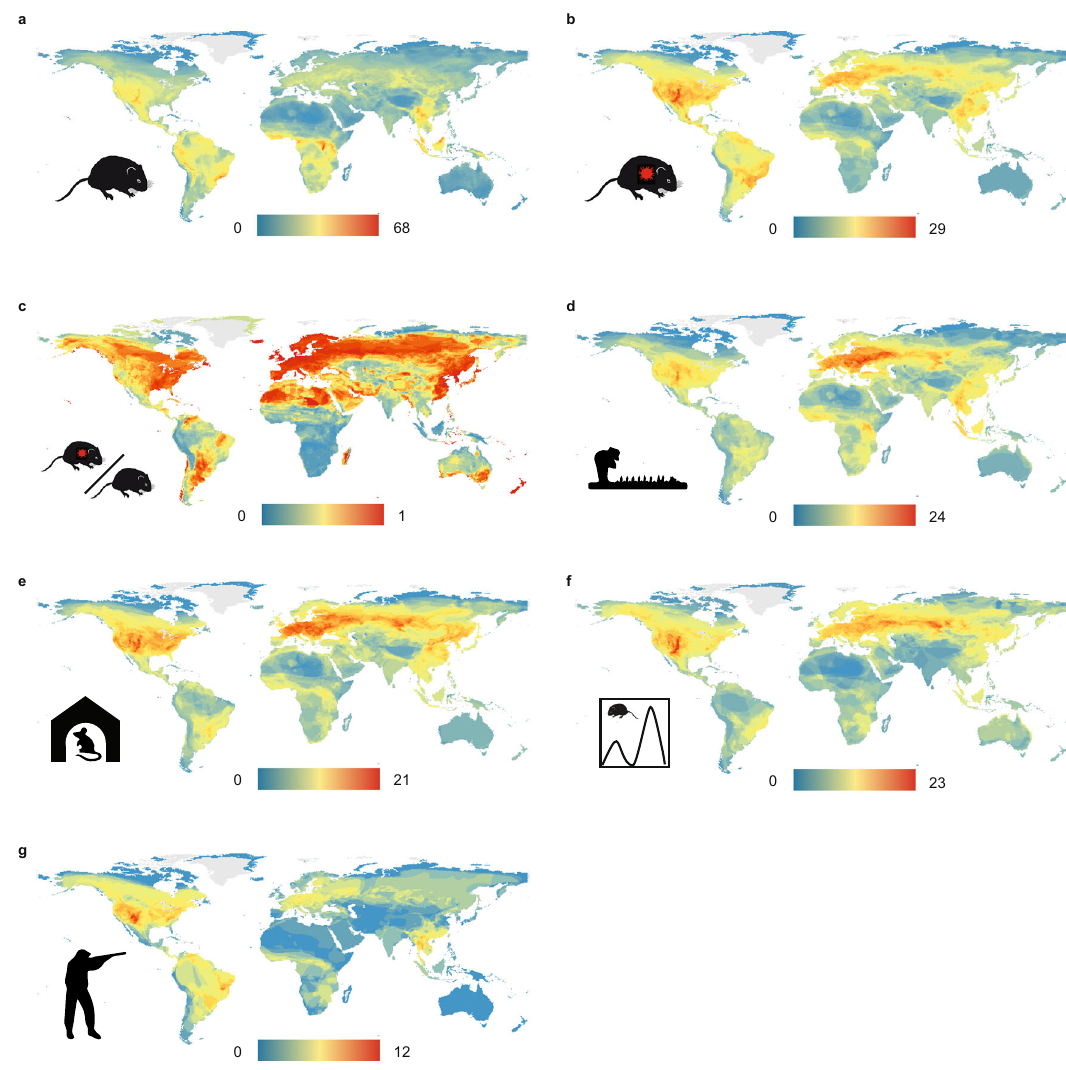
Fig. 5 | Global distribution of the number of rodent species by category. a All rodentspecies( n =2308), b reservoirrodents( n =282), c ratiobetweenthenumber of reservoir and total number of rodents, d rodents occurring in arti fi cial habitats ( n =186), e synanthropic rodents ( n =155), f rodents exhibiting pronounced